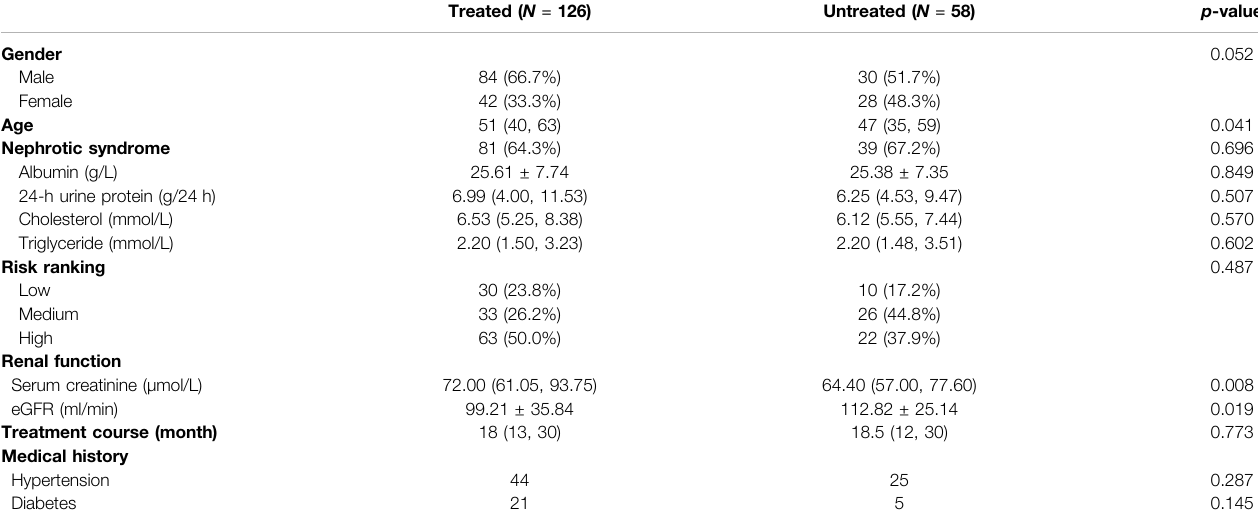
TABLE 1 | Baseline characteristics of the subjects (grouped according to whether they had used immunosuppressive therapy in the past). Treated ( N =